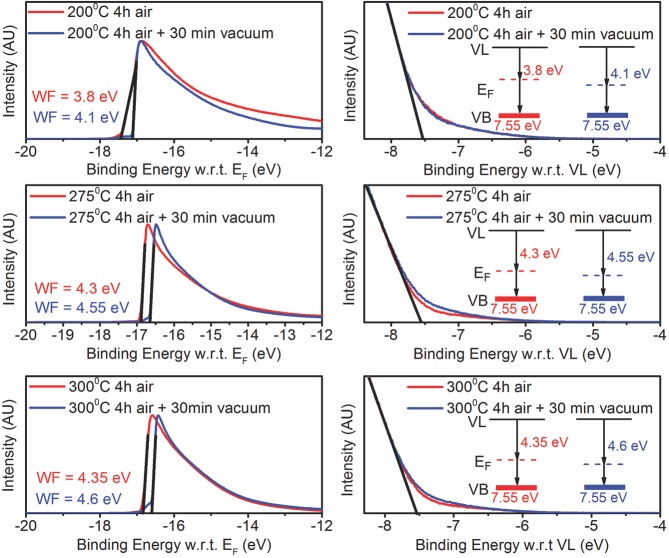
Ultraviolet photoemission spectra of samples annealed at 200, 275, and 300
°C for 4 h in air (red) and additional 30 min in vacuum (blue). Left:
secondary photoemission onset determining the position of the Fermi level.
Right: valence band region. (Inset: corresponding energy level diagrams).
The photon energy is 21.2 eV. The work function was found by using the
energy value at which the secondary photoemission begins (intersection of
black lines with x-axis on the left diagrams) and adding to
this the photon energy of 21.2 eV. The valence band edge energy was found by
extrapolating the slope of the absorption (black line on the right diagrams)
and reading the value of its intersection with the
x-axis.